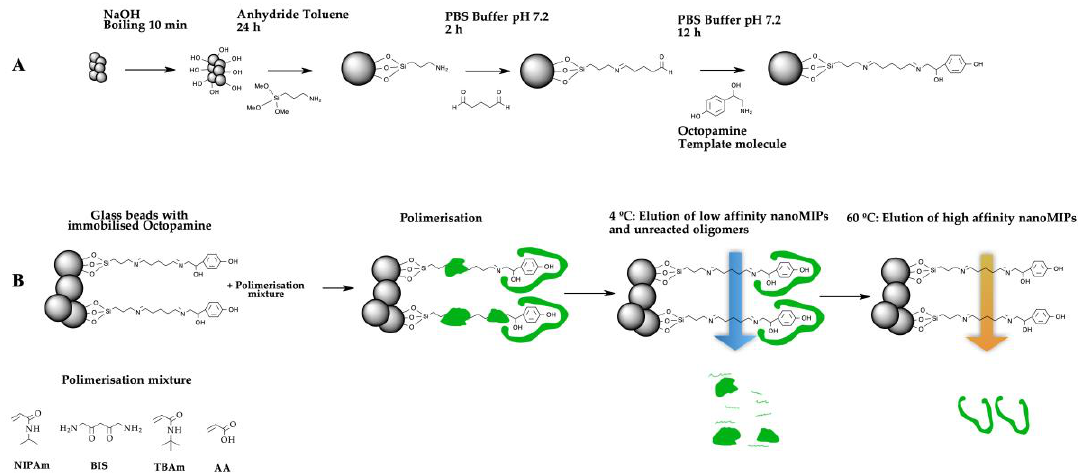
Figure 1. ( A ) Procedure for the immobilisation of octopamine on the surface of the solid support (glass beads). ( B ) Scheme of the synthesis of molecularly imprinted polymer nanoparticles (nanoMIPs) made for octopamine. Low-affinity particles and oligomers of the synthesis were washed at 4 °C. High-affinity nanoMIPs were collected at 60 °C.